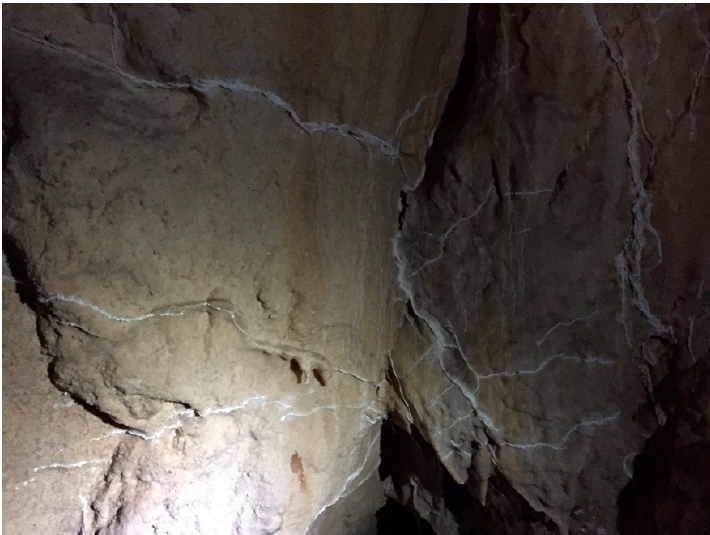
Figure 8. Fractures filled with neo-formed calcite interrupting the continuity of speleothems in the Cervo (Deer)